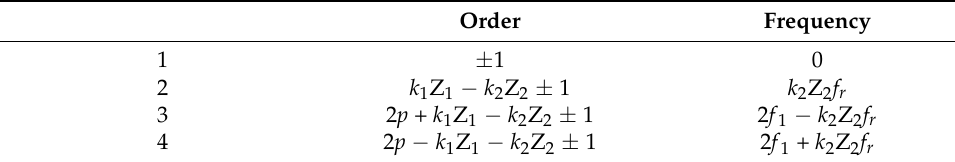
Table 2. Components of electromagnetic wave under static eccentricity.